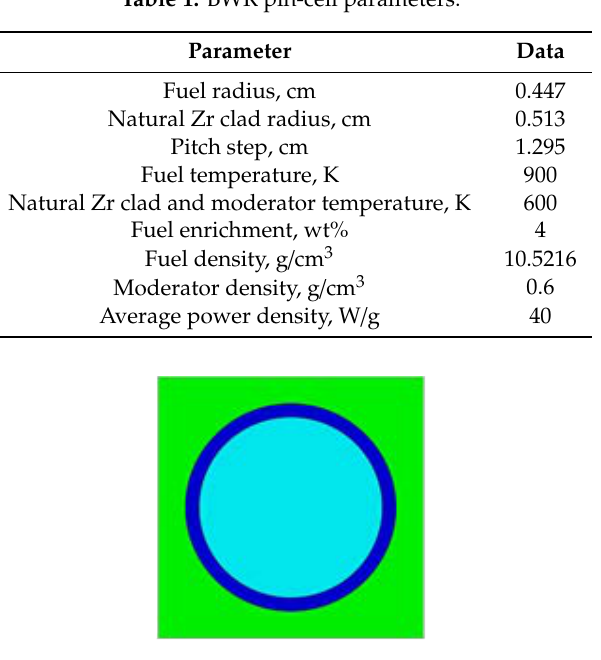
Figure 1. SCALE-6.2 model of BWR pin-cell.